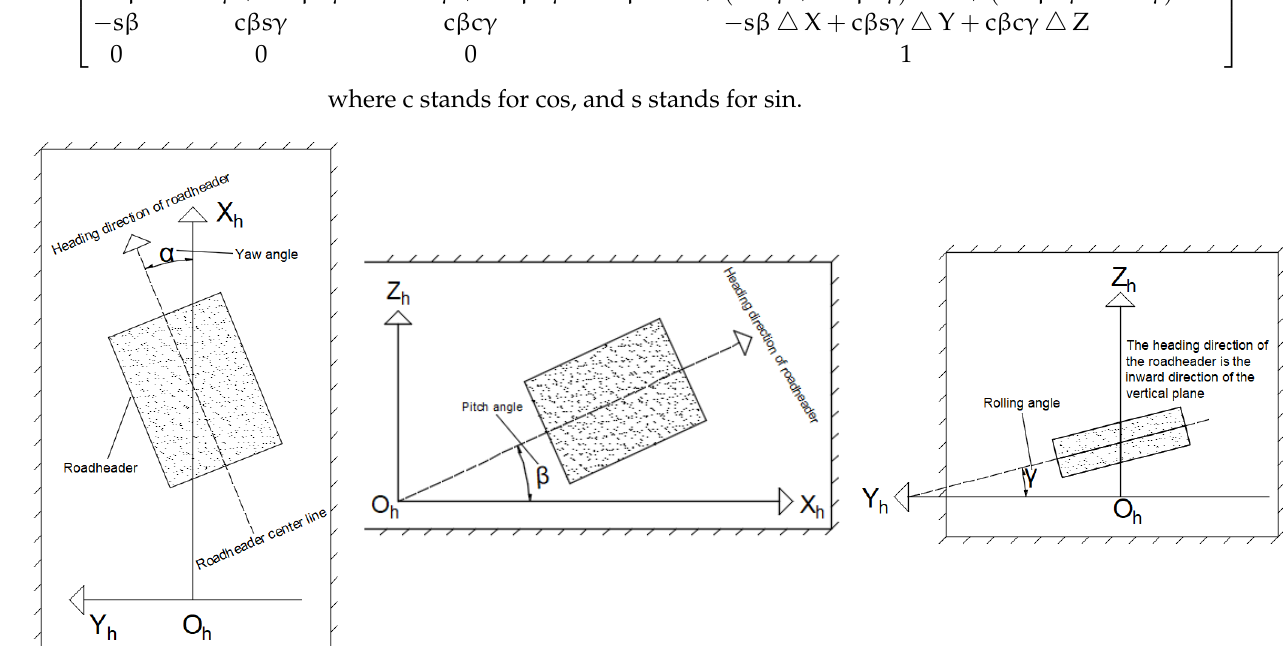
Figure 2. Schematic diagram of heading machine pose parameters.